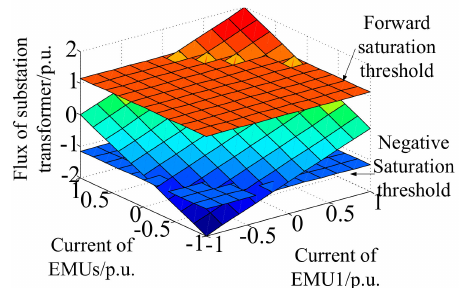
Figure 10. The relationship between the magnetic flux of the traction transformer and the current of EMU1 and EMUs.